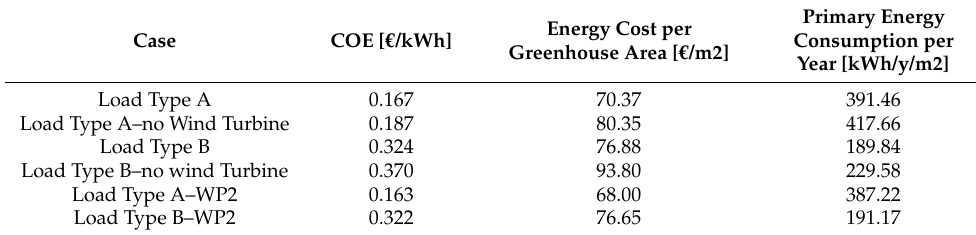
Table 8. Comparison between two greenhouse